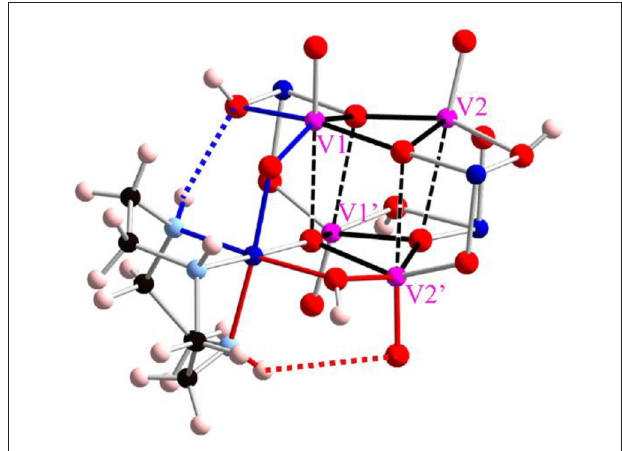
FIGURE 3 | Intramolecular hydrogen bonding interactions with tacn ligands. Pink, blue, and red balls show vanadium, cobalt, and oxygen atoms, respectively. The red and blue dotted lines show N–H · O (terminal) and N–H · OH ( µ 2 ), respectively. For the simplification, only one tacn ligand is shown, and three other tacn ligands are